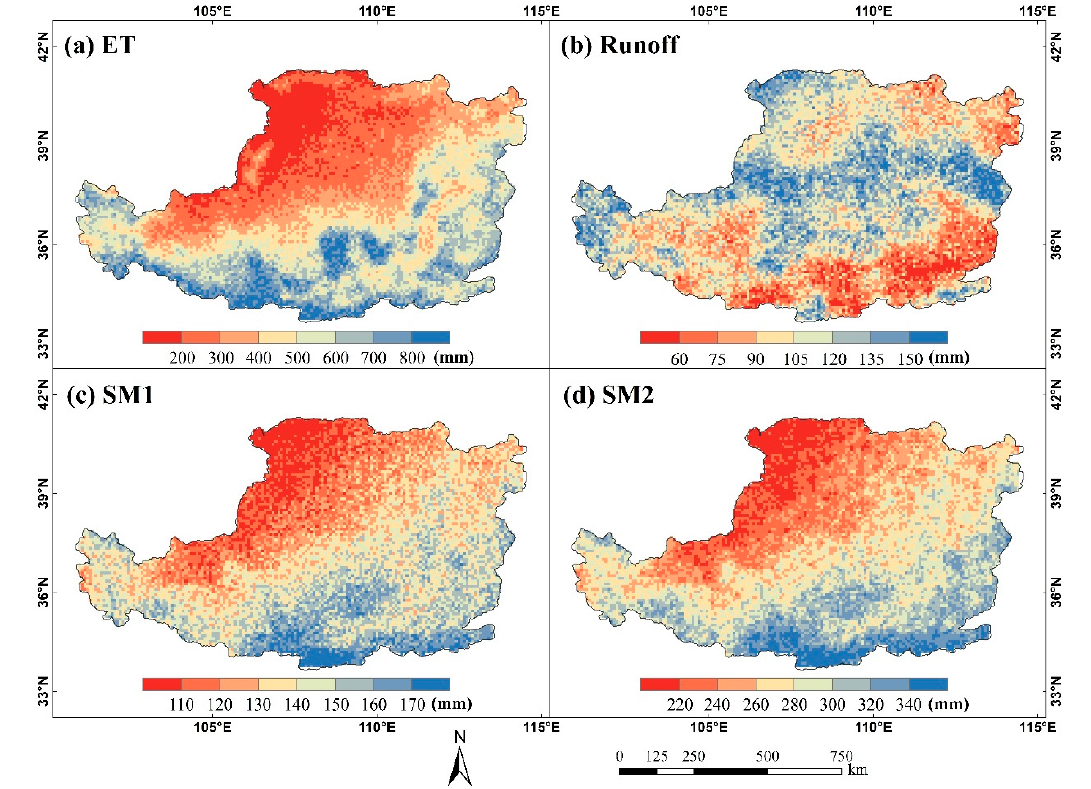
Figure 5. Spatial pattern of the multi-year mean value of four key HVs, ( a ) ET, ( b ) Runoff, ( c ) SM1, ( d ) SM2, simulated by VIC model from the period 1984–2015.